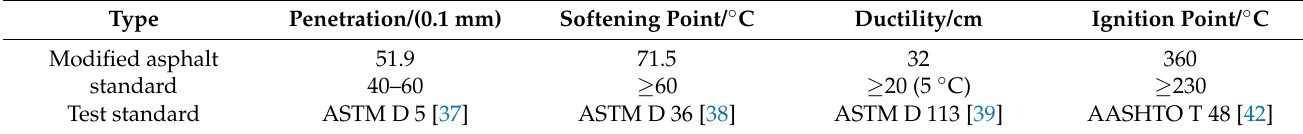
Table 1. Basic performance indicators of